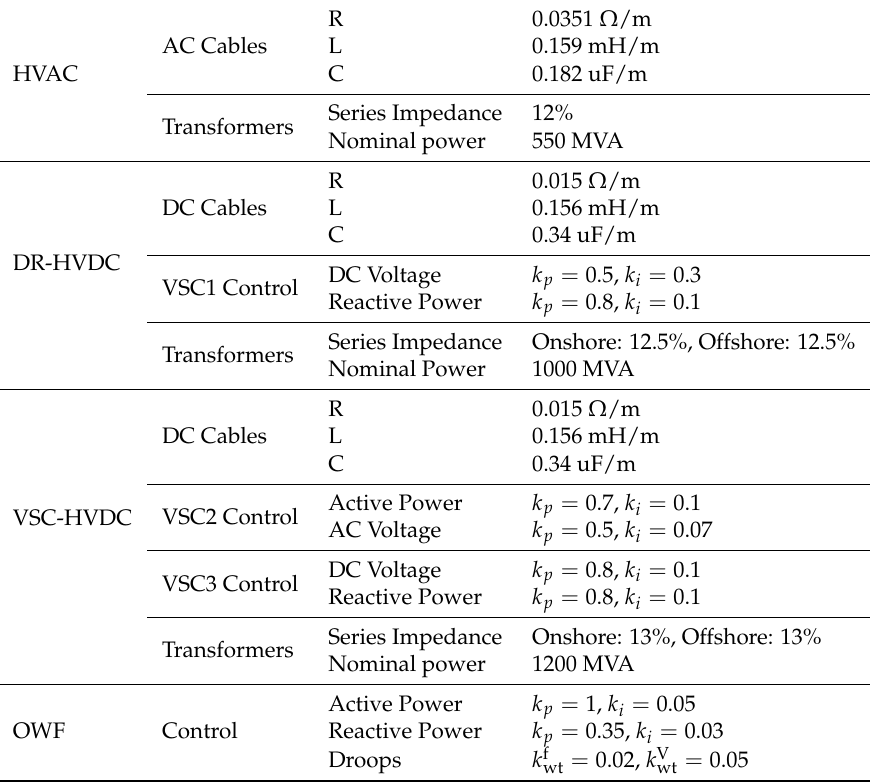
Table 1. Cables specifications and control parameters. OWF, offshore wind